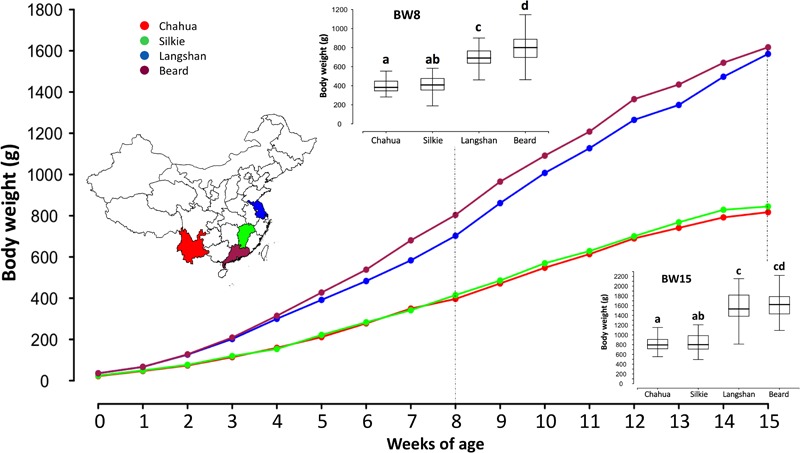
Growth curves of the four studied subpopulations from birth to 15 weeks of age. X-axis of the main plot shows chickens at different weeks of age, while y-axis presents their mean body weights. The inset map of China at the left side is marked with different colors to show the geographical origins of the four subpopulations. Boxplot insets, as two examples, show the mean differences of four subpopulations at 8 and 15 weeks of age. Letters a–d in the boxplots indicate the statistical differences between subpopulations. Subpopulations with different letters have significantly different means (p < 0.05). For example, at 8 weeks of age, the mean body weights between Chahua and Silkie are not significantly different, as they both are labeled with the letter “a.” On the contrary, the mean body weight of Langshan is significantly different from that of Beard, as they are labeled with different letters.